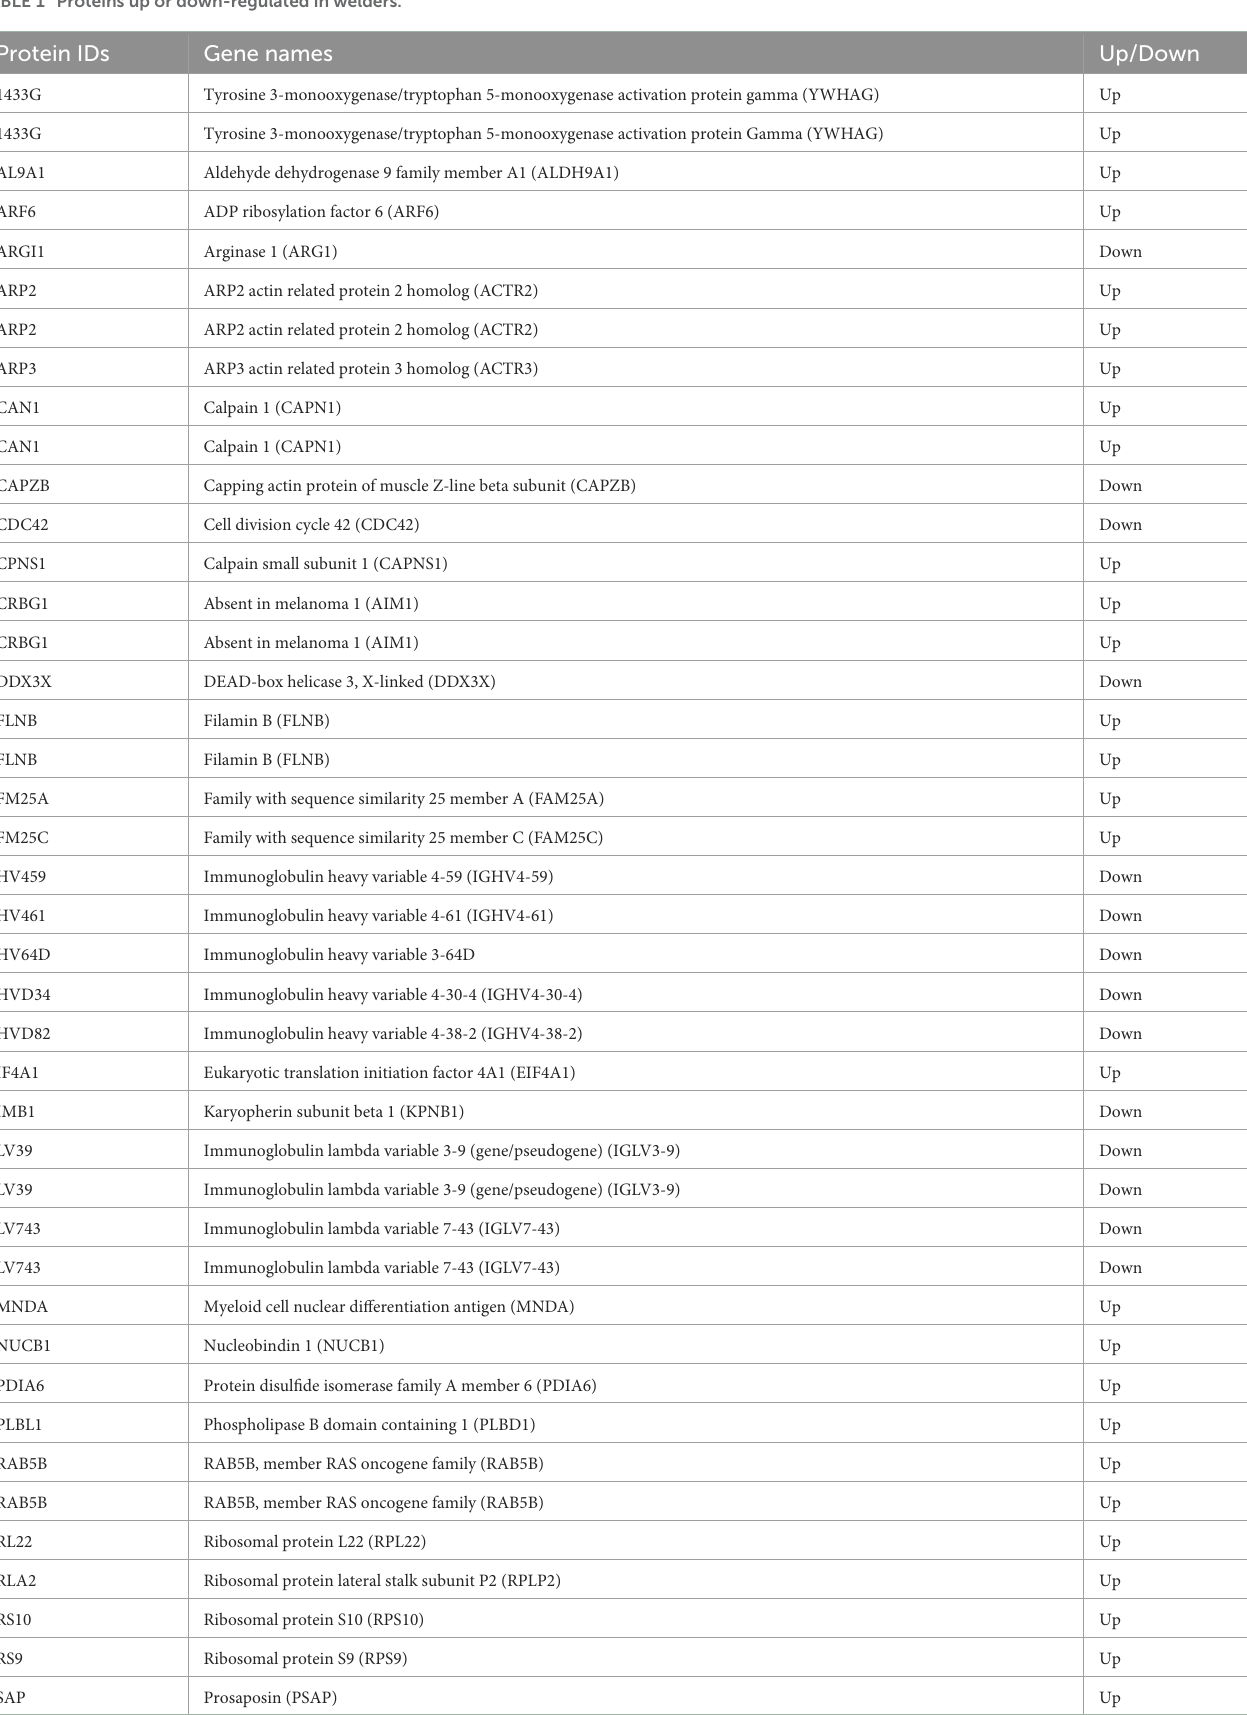
TABLE 1 Proteins up or down-regulated in welders. Protein